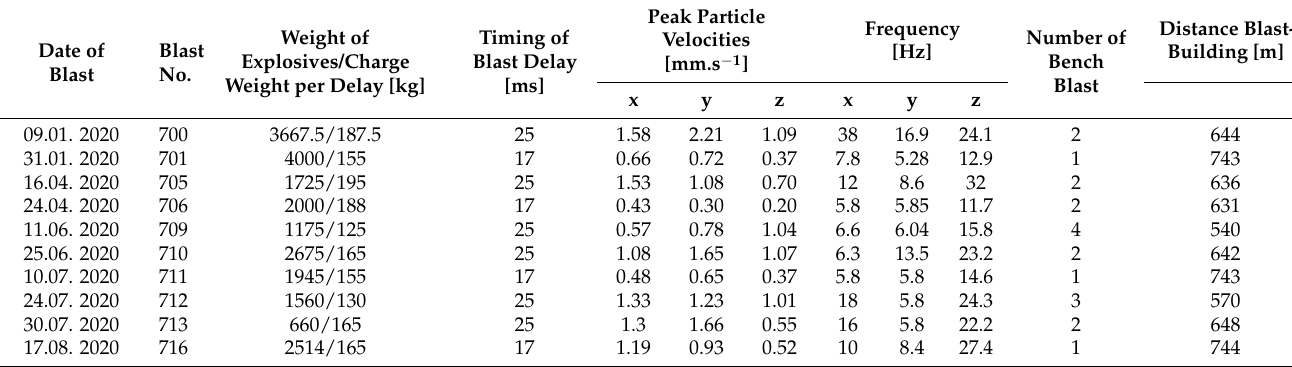
Figure 12. Graphical course of the weight of explosives according to the performed blasting work (source: author). Table 7. Measured values of maximum particle velocities at individual delays of millisecond timing during daily aperture blasting in Trebejov Quarry